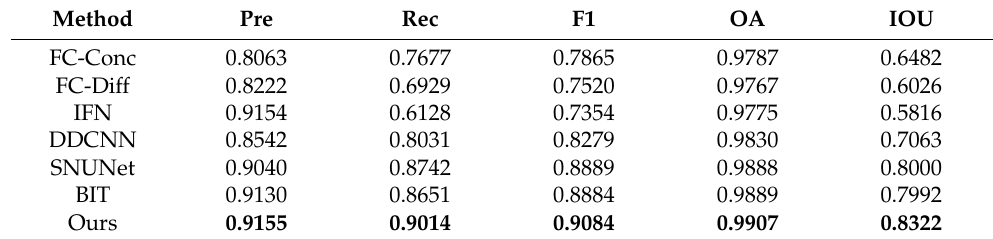
Table 1. The comparison results on the LEVIR-CD dataset.